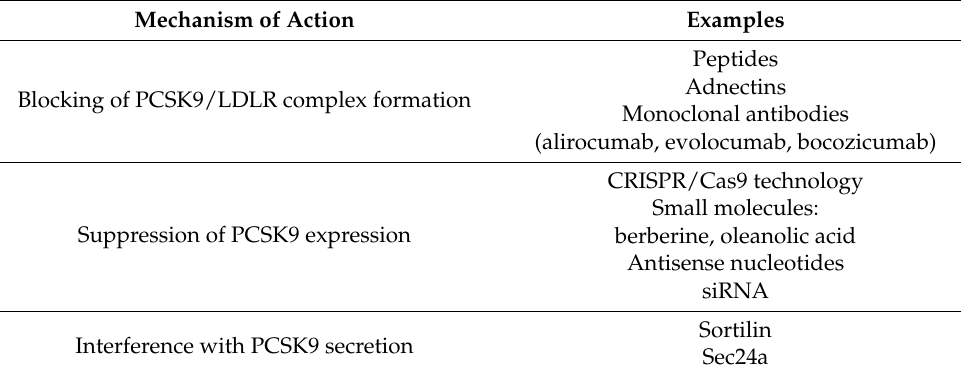
Table 1. PCSK9 inhibitors and their mechanism of action. Mechanism of Action